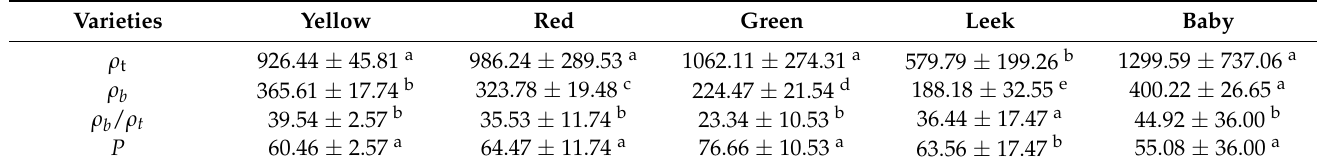
Table 2. Volume and density